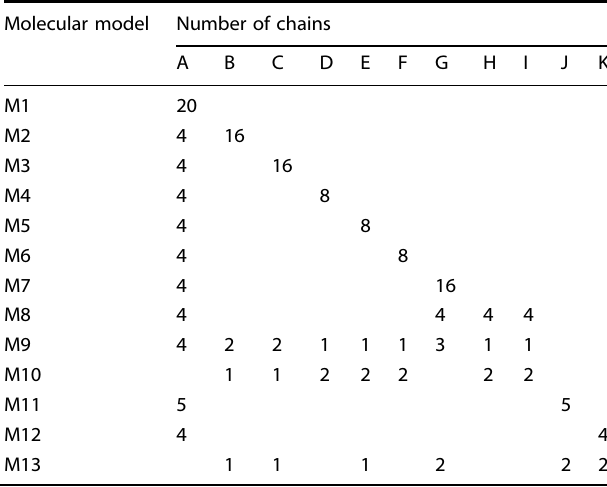
Table 2. Details of the unaged and aged molecular models. Molecular